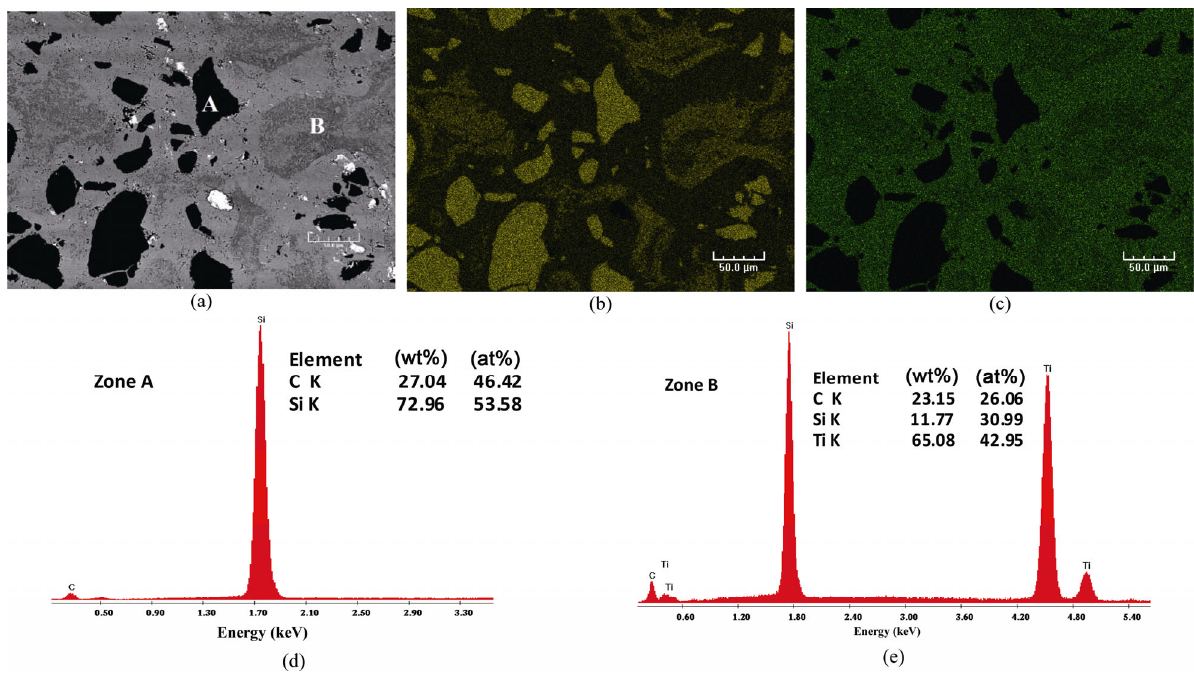
Fig. 6 (a) EDX micrograph of the bulk material obtained after sintering at 1400 ℃ for 20 min, (b) Si mapping, (c) Ti mapping, (d) the A zone, and (e) the B zone.